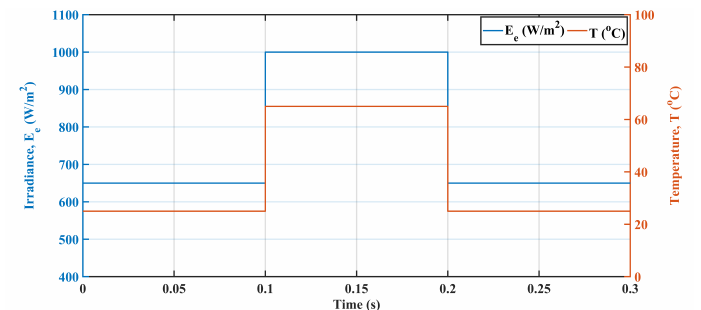
Figure 7. Variable E e and Variable T profiles w.r.t time.